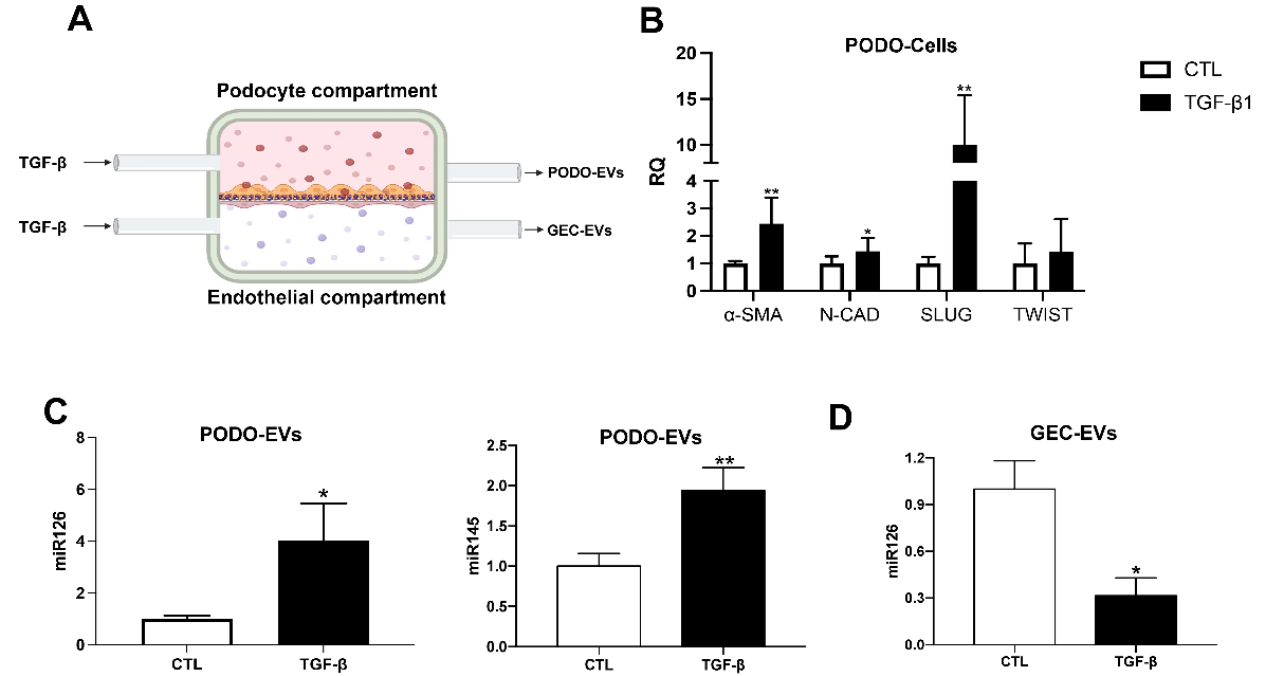
Figure 3. Schematic image of the millifluidic dynamic glomerular model ( A ) The podocyte and endothelial compartments were separated by a membrane coated with collagen type IV. TGF- β was introduced into the circuit through the inlet channels, while the outgoing medium, enriched with EVs, was collected separately. ( B ) Relative quantification of EMT genes ( α -SMA, N-CAD, SLUG and TWIST) in podocytes (PODO-Cells) cultured in the glomerular model and treated with TGF- β . Untreated podocytes were used as control (CTL) (* p < 0.05: ** p < 0.01 vs. CTL). ( C , D ) Relative quanti- fication of miR126 and miR145 in EVs ( C ) from TGF- β and CTL podocytes (PODO-EVs) and ( D ) glomerular endothelial cells (GEC-EVs) (n = 4 independent experiments) (* p < 0.05: ** p < 0.01 vs. CTL).